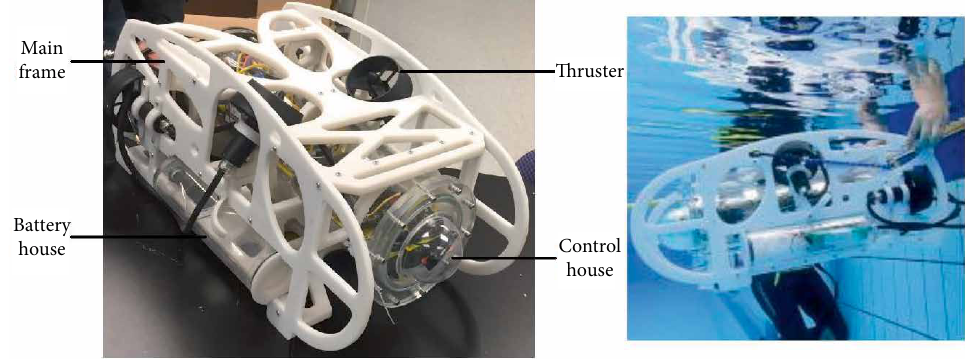
Figure 1: AUV and competition